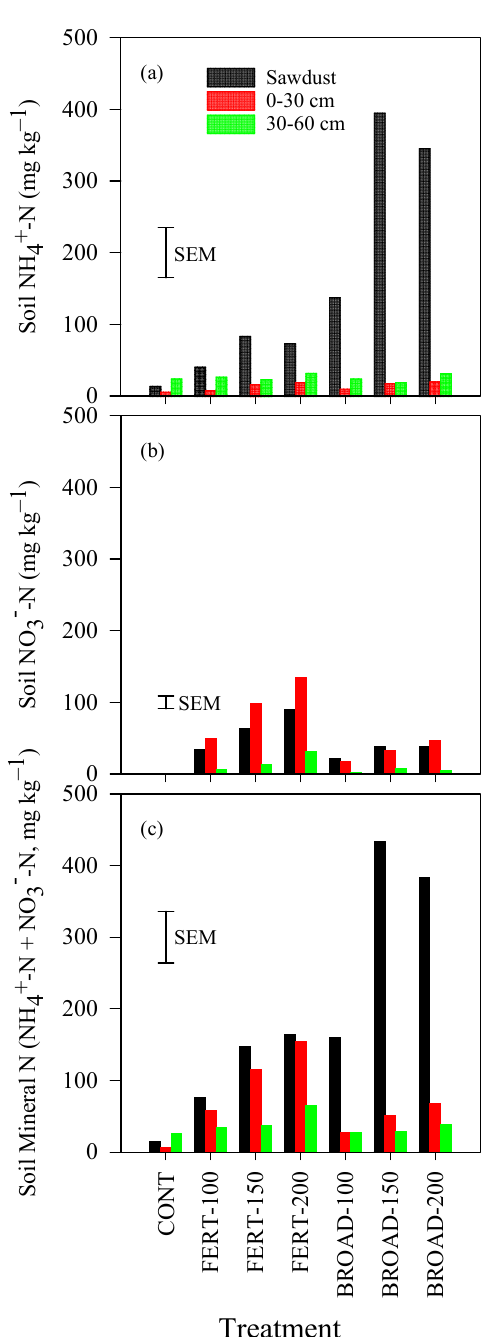
Figure 4. Concentrations of ( a ) Ammonium nitrogen (NH 4 + -N), ( b ) nitrate nitrogen (NO 3 − -N) and ( c ) mineral nitrogen (NH 4 + -N + NO 3 − -N) at 0–30 cm and 30–60 cm soil depth and in the sawdust mulch layer with annual applications of N through fertigation (FERT-100, 100%; FERT-150, 150%; FERT-200, 200%) and broadcast (BROAD-100, 100%; BROAD-150, 150%; BROAD-200, 200%) methods to highbush blueberry ( Vaccinium corymbosum ) in fall 2018. Error bars represent the standard errors of the means (SEM) for comparing all values (n = 28 and df = 21).